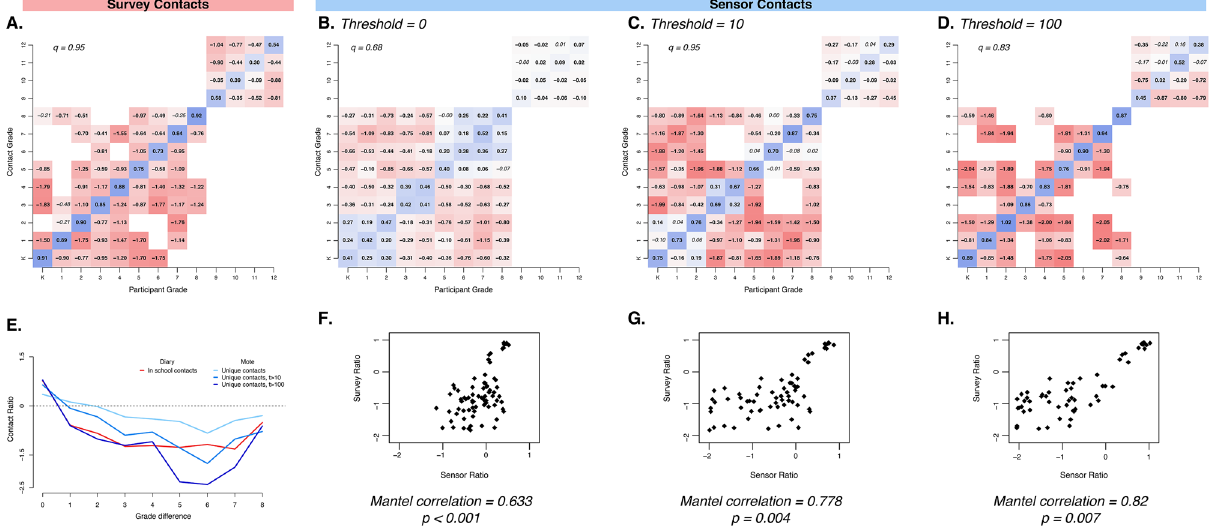
Figure 3. Age-specific mixing matrices generated from in-school survey contacts and unique sensor- recorded contacts in a US school setting at various cumulative contact thresholds. Matrices are presented as log-10 ratio of observed contacts relative to expectation under proportionate mixing assumptions for survey- reported in-school contacts ( A ) and sensor-recorded unique contacts with thresholds of 0 ( B ), 10 ( C ), and 100 ( D ) cumulative contacts. Blue colours indicate more contacts than expected under proportionate mixing assumptions, and red colours indicate less mixing than expected. Bolded ratio values deviate significantly from the null expectation, ɑ = 0.05, and q equals the degree of assortative mixing. Scatterplots (F–H) show the corresponding i,j values of the survey- and sensor-based mixing matrices at each threshold (0, 10, 100). ( E ) shows the average departure from proportionate mixing as a function of difference between grade for each